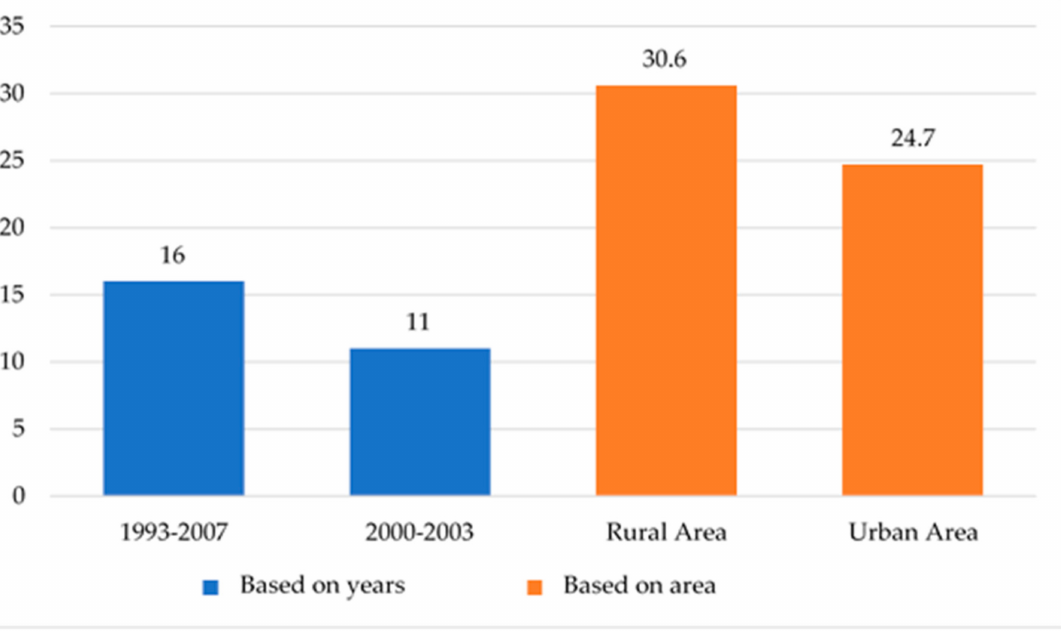
Figure 2. Indonesian DBM prevalence through the